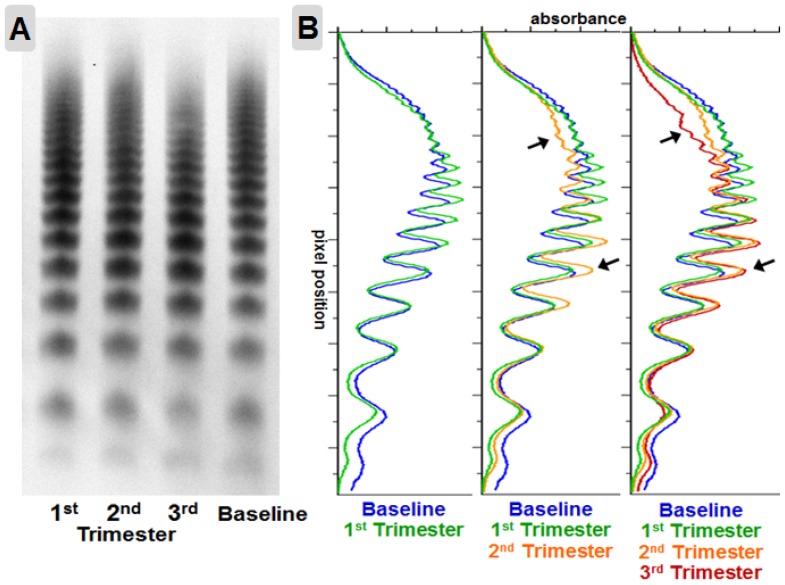
Loss of higher weight VWF multimers in pregnancy.A normalized 1% multimer gel (A) and densitometry (B) of plasma VWF multimers from a single pregnancy demonstrating the most commonly observed pattern of shifted VWF multimers (arrows) in the second trimester (orange) and third trimester (red) compared to baseline VWF (blue).